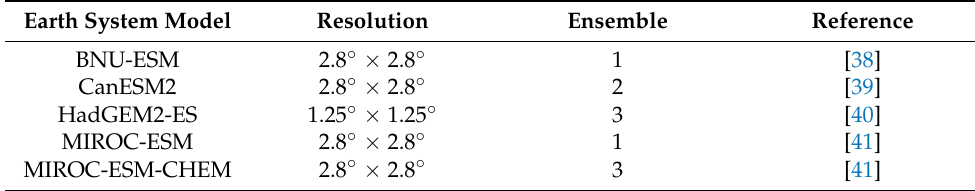
Table 1. Earth System Models in CMIP5 used in this